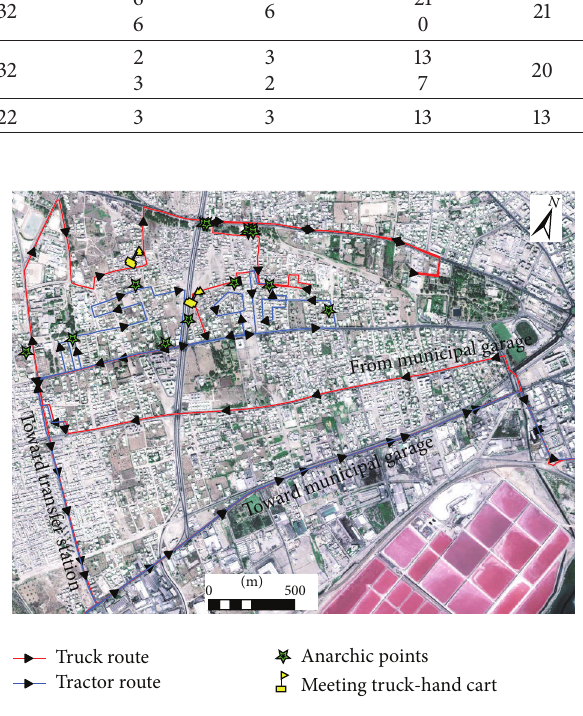
Figure 6: Optimized route for Scenario